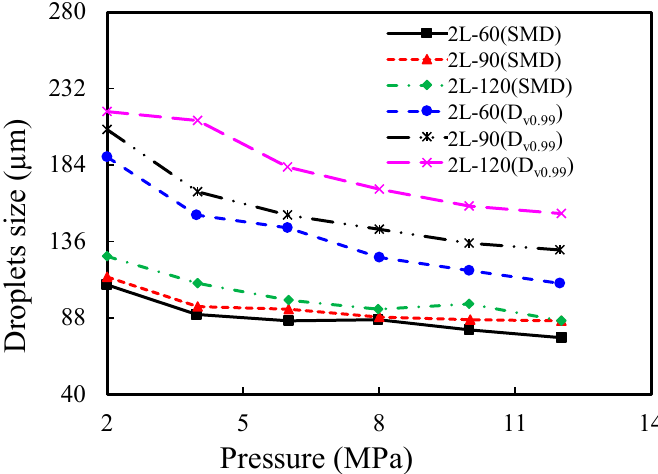
Figure 10. Discharge pressure effect on water droplet size [20].